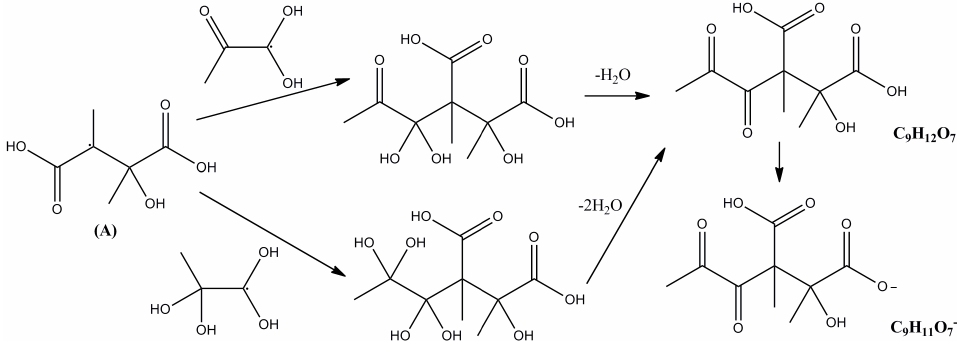
Scheme 7. The formation of C 9 H 12 O −